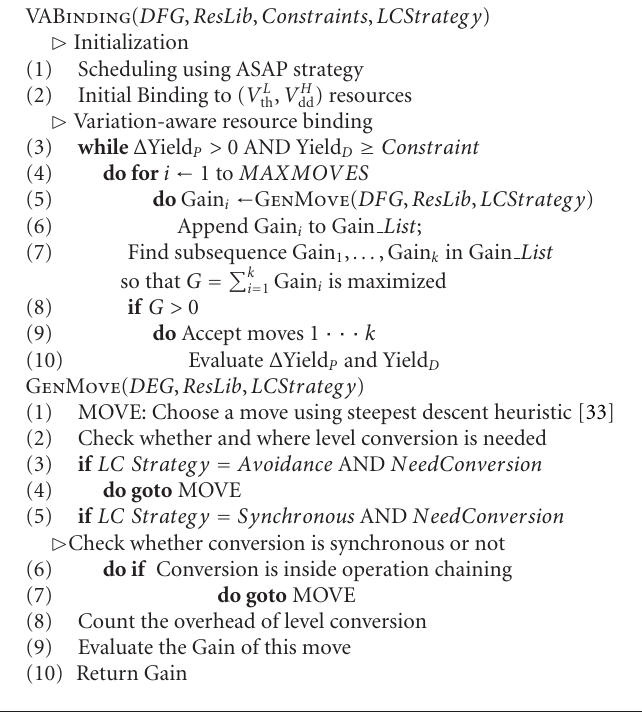
Algorithm 1: Outline of the variation-aware resource binding